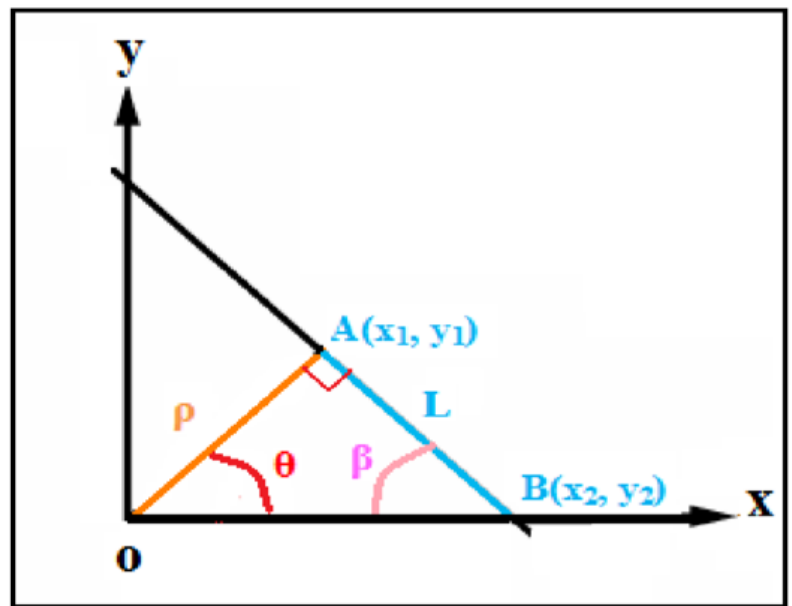
Figure 12. Determination of attributes by the Hough